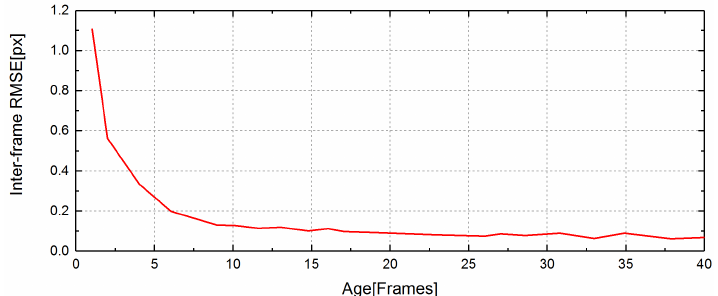
Figure 4. RMSE (root-mean-square error) of inter-frame feature position as a function of the survival age. The RMSE is lower if the feature’s age is